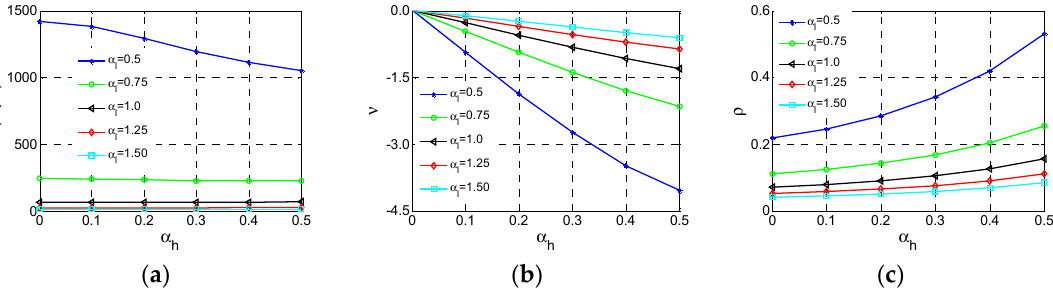
Figure 6. The changes of the effective properties with respect to the α h and α l for Type A cell: ( a ) effective Young’s modulus E ; ( b ) effective Poisson ratio v ; ( c ) relative density ρ